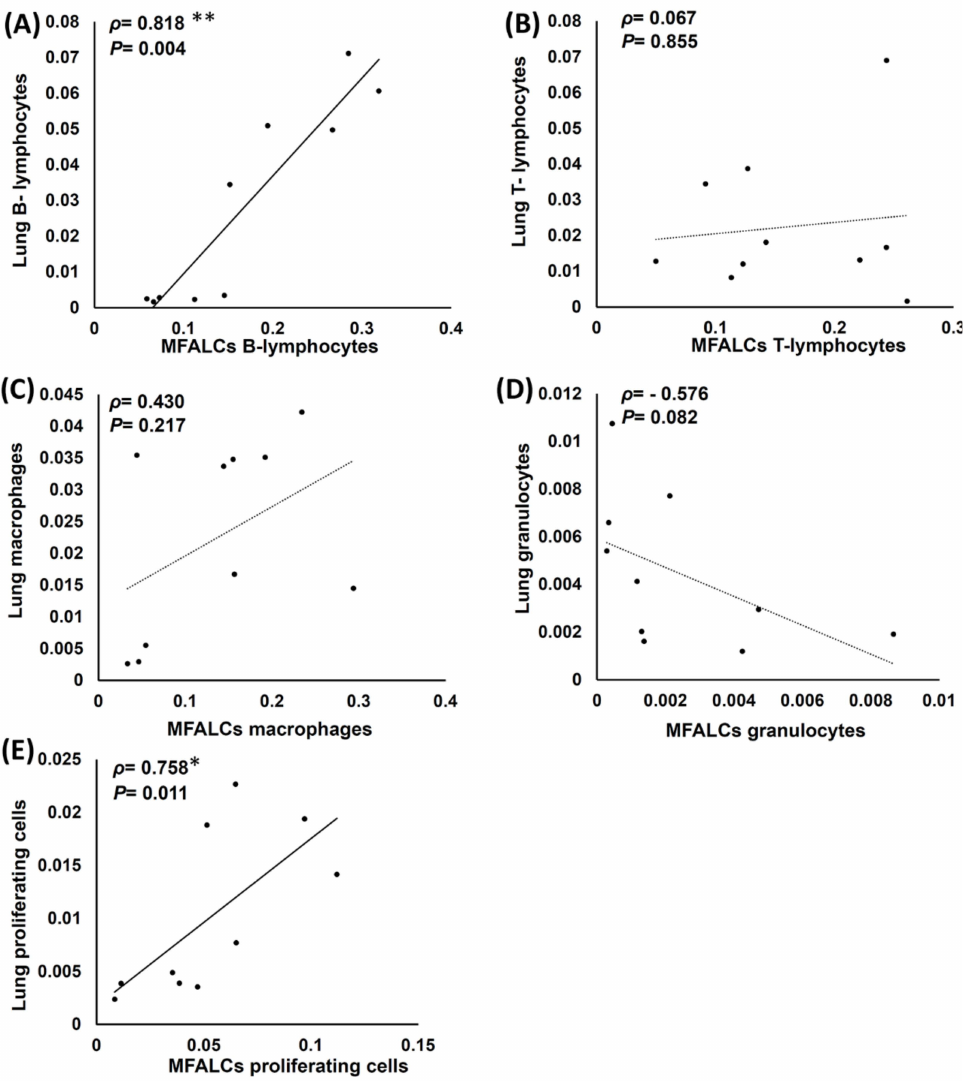
Figure 8. Analysis of the correlations between the immune cell populations and the proliferating cells in the lungs and mediastinal fat associated-lymphoid clusters (MFALCs) in saline and dexamethasone group mice. ( A – E ) Representative graphs showing Spearman’s correlation between the immune cell populations of the lungs and MFALCs ( A ), B-lymphocyte populations of the lungs and MFALCs ( B ), macrophage populations of the lungs and MFALCs ( C ), granulocyte populations of the lungs and MFALCs ( D ), proliferating cell populations of the lungs and MFALCs ( E ). The data were analyzed by Spearman’s correlation test, where n = 10, ρ : Spearman’s rank-order correlation coefficient. * Significant, p < 0.05, ** Highly significant, p <